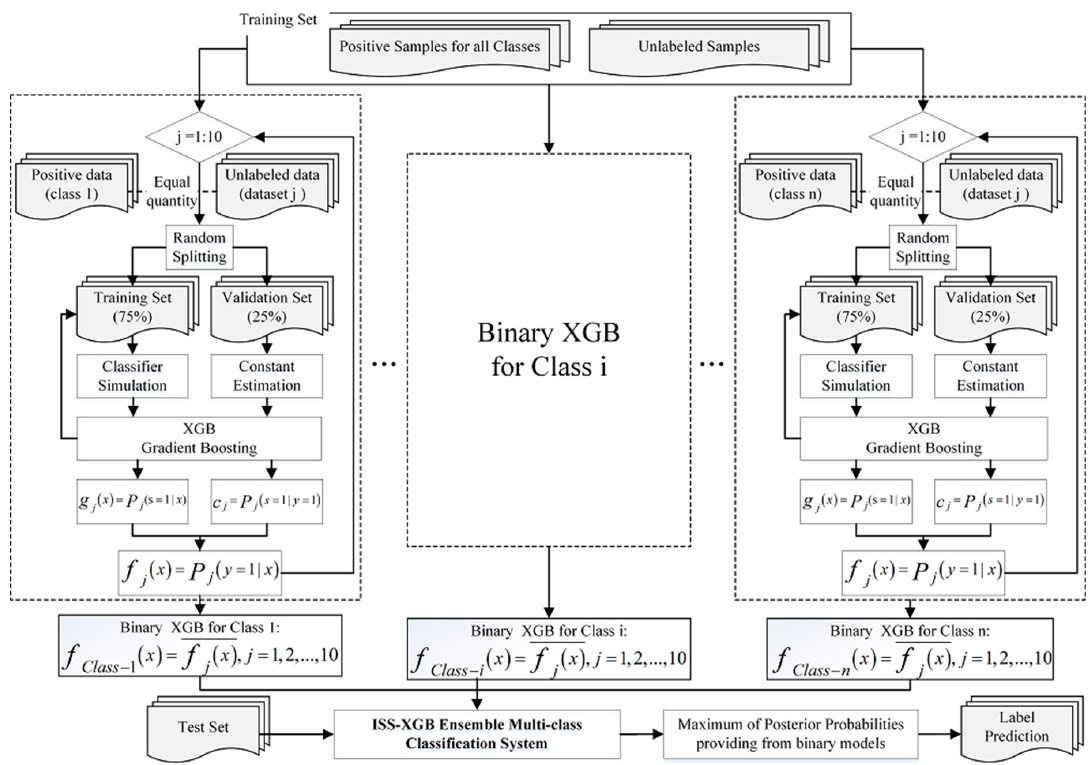
Figure 1. Workflow of the impartial semi-supervised learning strategy based on extreme gradient boosting (ISS-XGB) ensemble algorithm.